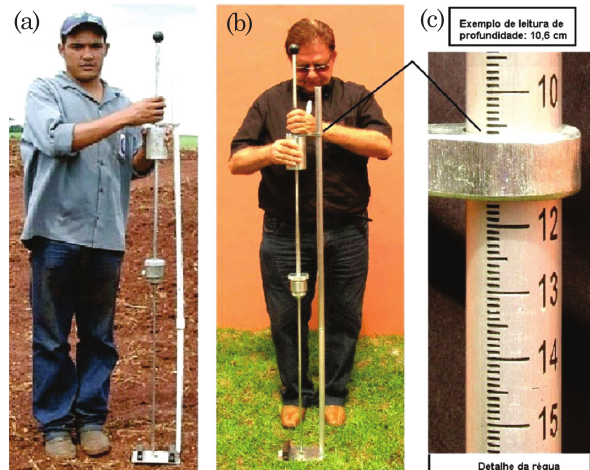
Figura 1. Detalhe do equipamento em teste, indicando: (a) a régua no protótipo em plástico; (b) o modelo definitivo de alumínio; c) o detalhe do nível de leitura do modelo definitivo.